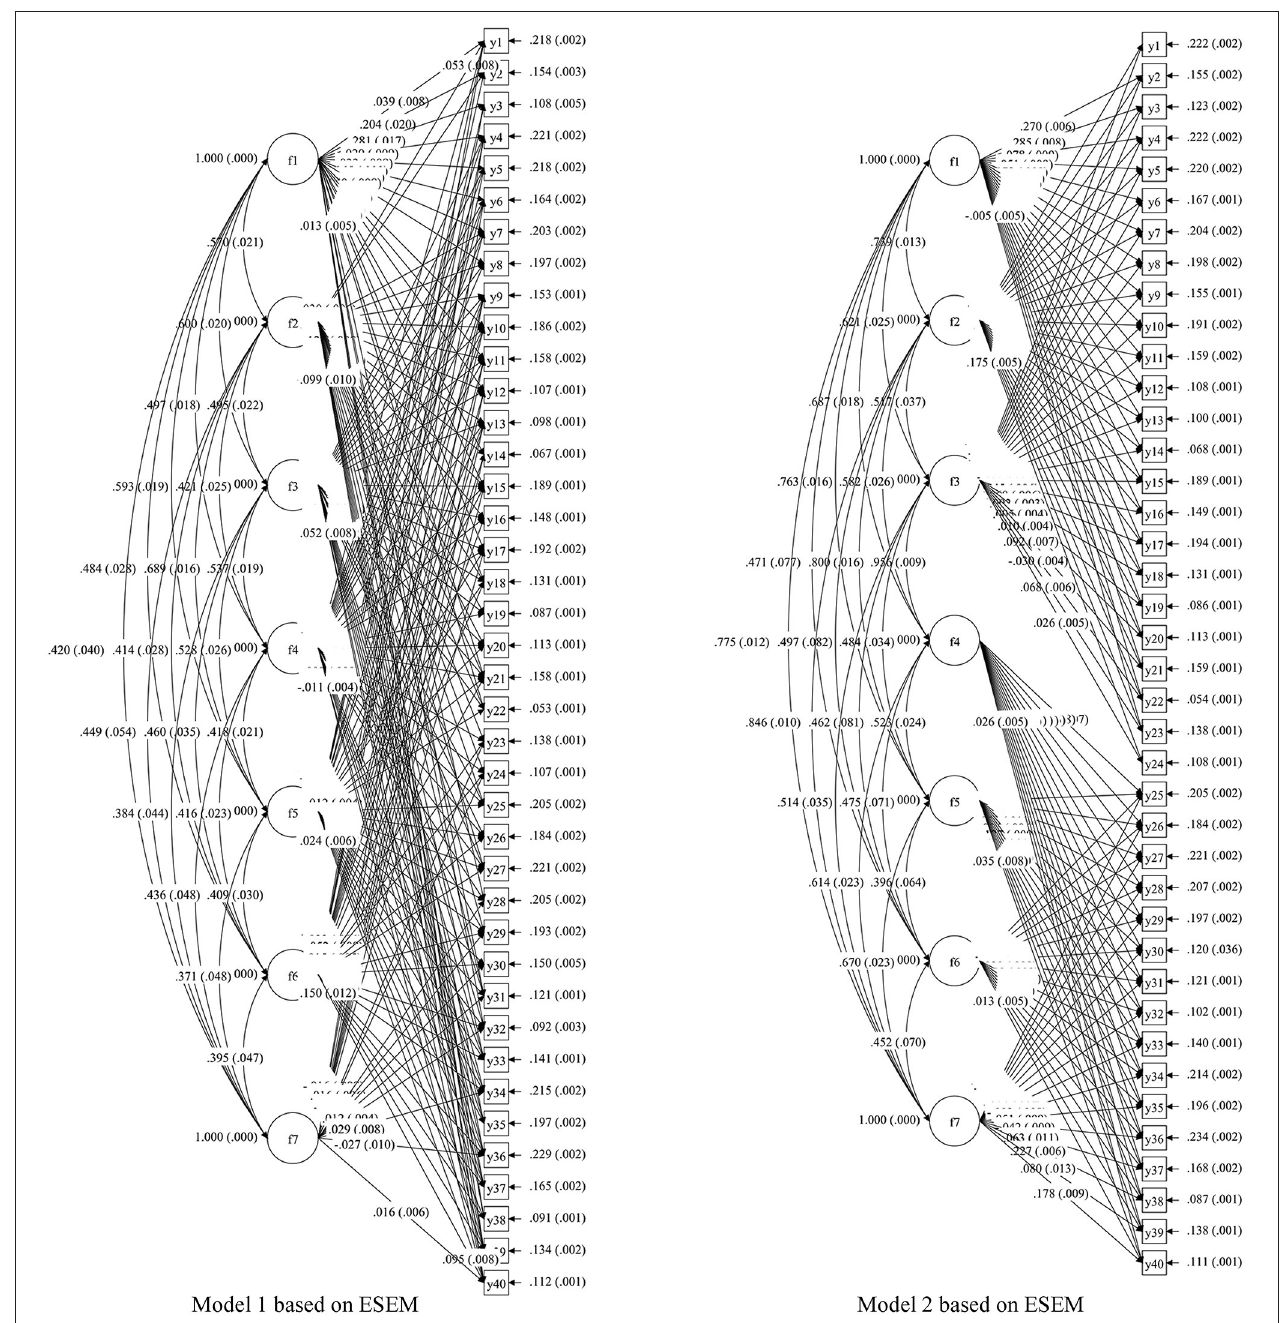
FIGURE 2 | Structural diagram of two hypothetical listening cognitive